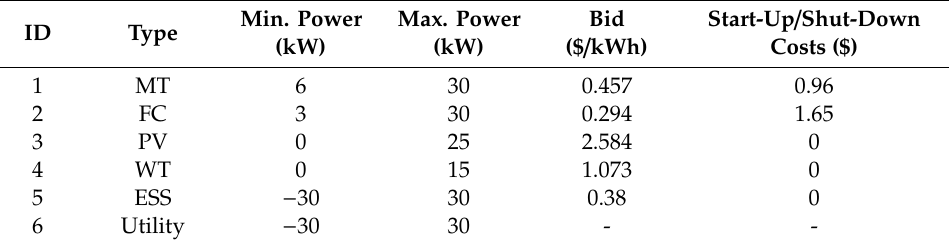
Table 1. Limits and bids of installed distributed generator sources.